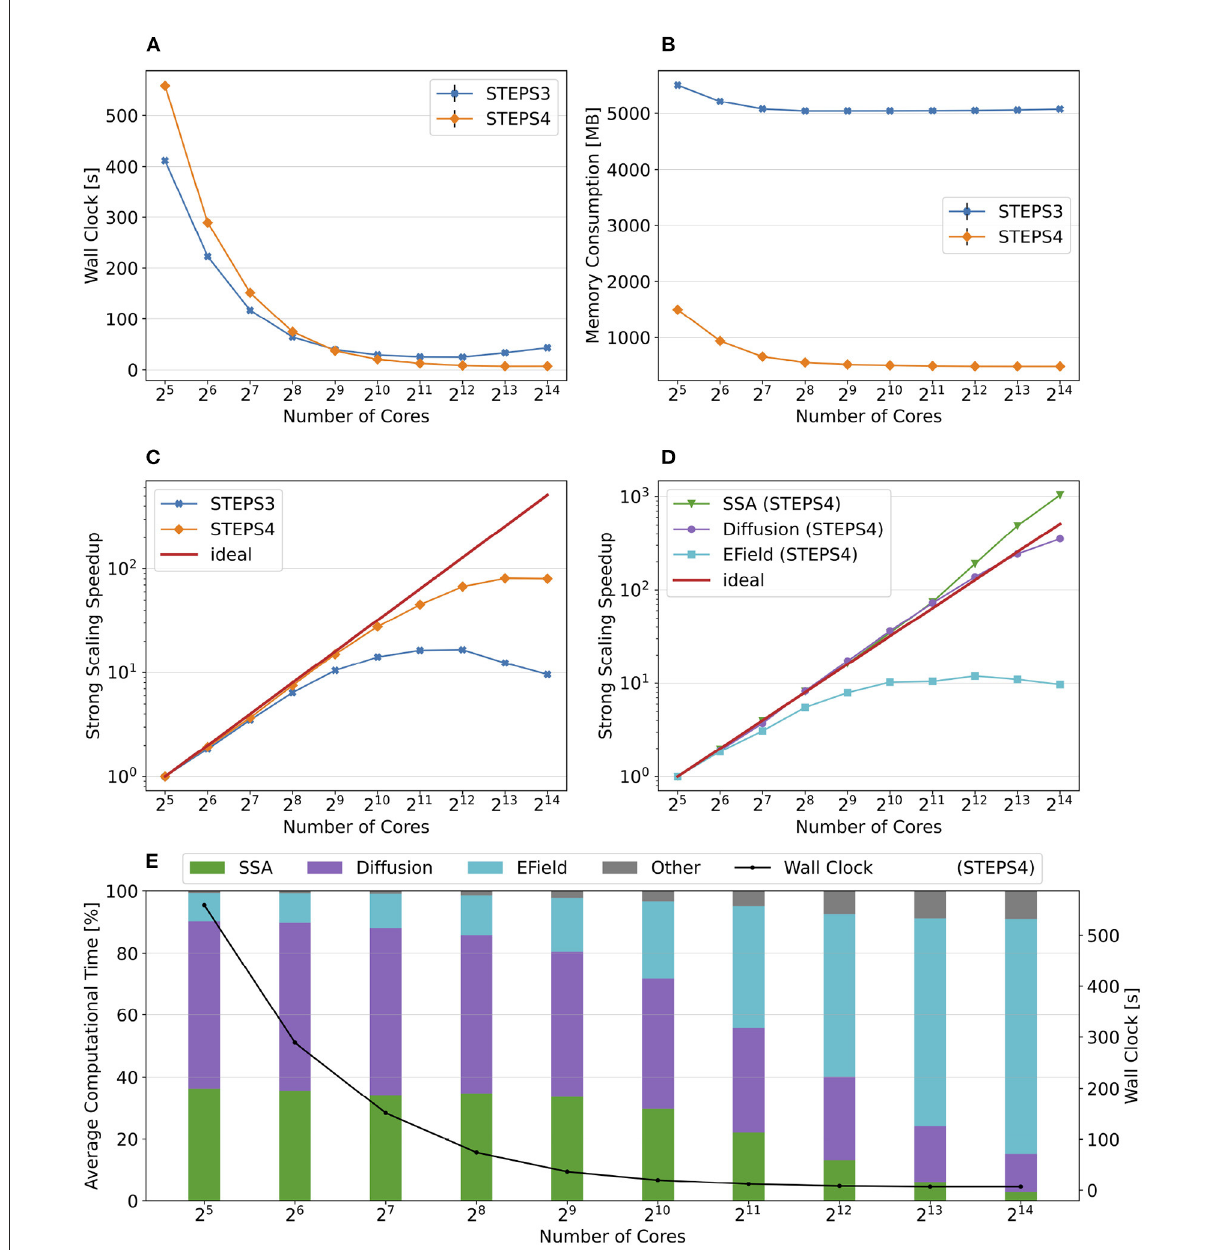
FIGURE10 The performance results and scalability of the calcium burst complete model. (A) STEPS 4 performs slightly worse than STEPS 3 in low core count simulations, but reaches similar performance with 2 9 = 512 cores, and outperforms STEPS 3 afterward. (B) STEPS 4 requires about 1.5GB for the 2 5 = 32 core baseline simulations. Its memory footprint quickly decreases to 500MB for 2 9 = 512 cores and above. STEPS 3 consumes more than 5GB of memory per core for the whole series. (C) STEPS 4 achieves a better scalability compared to STEPS 3. (D) Component scalability analysis of STEPS 4. The SSA operator shows super-linear speedup throughout the series. The diffusion operator also exhibits linear speedup until 2 13 = 8,192 cores. However, the EField operator shows limited scalability with maximum 10x speedup with 2 10 = 1,024 cores and above. (E) Component proportion analysis of STEPS 4. The EField operator progressively dominates the computational time, from 10% in the baseline simulations to 76% in the 2 14 = 16,384 core simulations, due to its limited scalability compared to the other operator components.